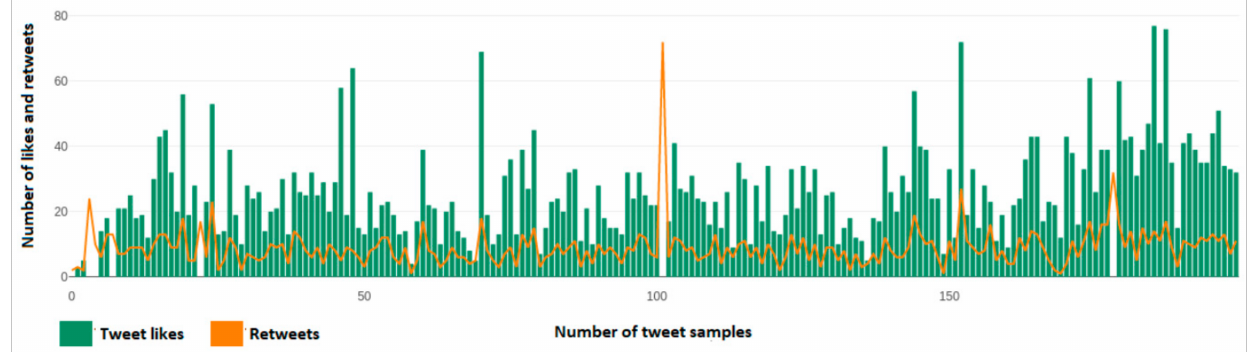
Figure 16. Number of likes and retweets per tweet for @kinimallagis (200 tweet sample). Figure 17 depicts the number of identified tweets, which include the negative hashtag "#N ∆ _ θελατε " from a dynamic sample of 100 tweets taken throughout Twitter. This hashtag is negative towards New Democracy party and is an indication of frustration of voters towards the policies of this particular political party. Axis y depicts the number of each tweet over the total 100 tweet sample, while the x axis depicts the date and time frequency of each tweet.